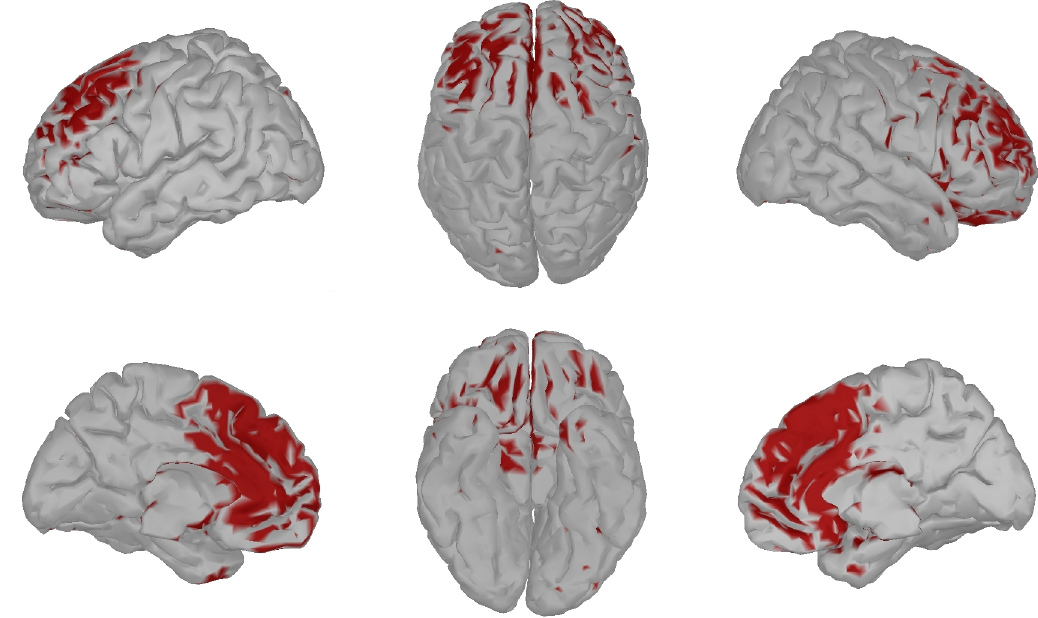
Fig 4. Healthy controls: p-value brain map. Color shows voxels with p < 0.05.